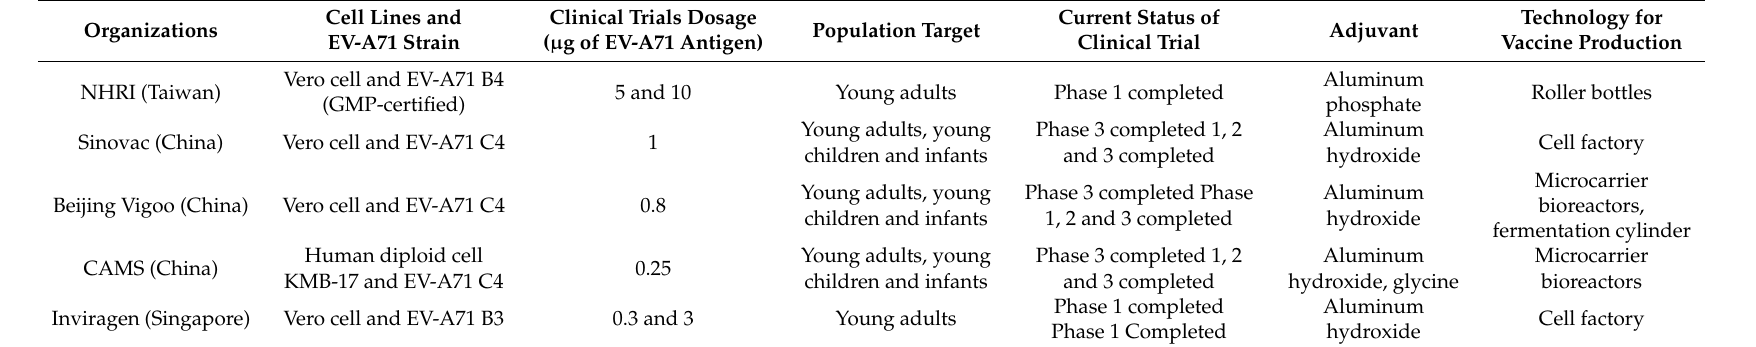
Table 2. Five EV-A71 inactivated vaccines at different clinical phases of